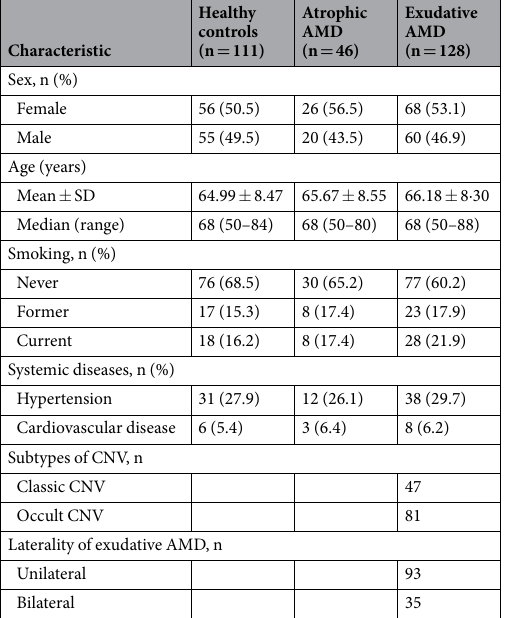
Table 1. Demographic and Clinical Characteristics of Subjects. AMD = age-related macular degeneration; CNV = choroidal neovascularization. Data were expressed as number (%), mean ± SD, or median (range). Chi- square tests were used for comparisons of the categorical variables; One-way analysis of variance (ANOVA) was used for comparisons of the continuous variable (age). All P > 0.05 for differences of sex, age, smoking status, hypertension and cardiovascular disease among healthy controls, atrophic AMD and exudative